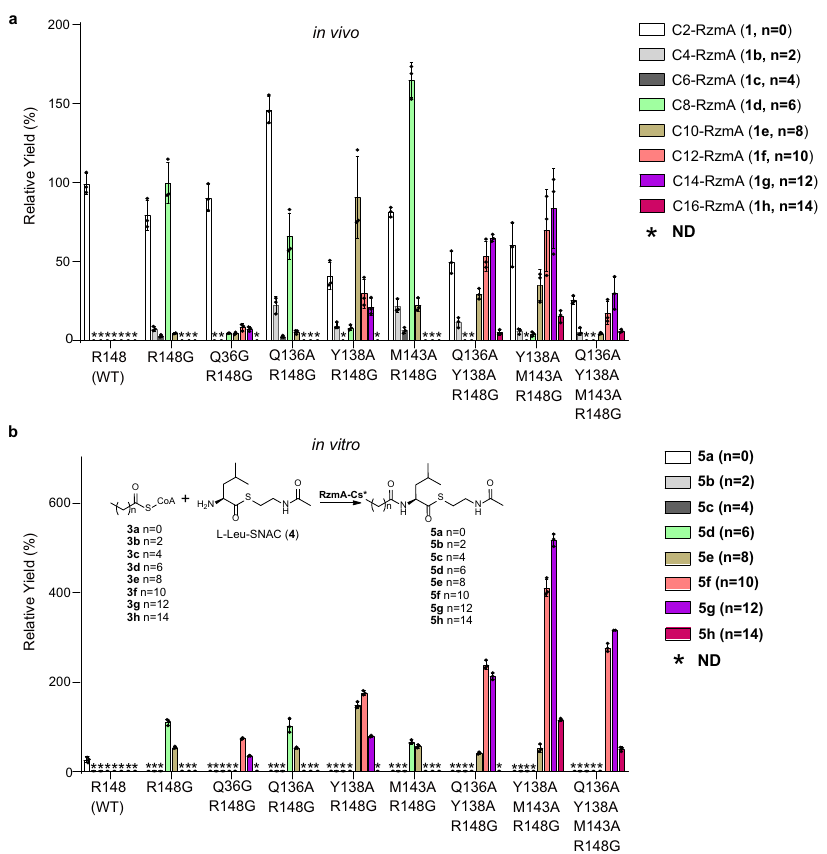
Fig. 7 Structure-guided in-depth engineering of the Cs domain of rhizomide. a The relative yields of rhizomide derivatives ( 1 , 1b – 1h ) with different acyl chains (C2-C16) in S. brevitalea DSM 7029 harboring the corresponding point-mutated rzmA . The yield of 1d (C8-RzmA) in RzmA-R148G was quanti fi ed as a reference (100%) for the peak areas of EICs. Related chemical structures of rhizomide derivatives were given in Fig. 1b in which the ‘ n ’ represents the number of CH 2 group. b The relative yields of acyl-Leu-SNAC ( 5a – 5h ) in the in vitro acyl-CoAs substrate competition experiment of RzmA-Cs variants. The yield of 5d (C8-Leu-SNAC) in RzmA-Cs R148G was quanti fi ed as a reference (100%) for the peak areas of EICs. The products that were not detected (ND) by UPLC-MS are marked with asterisks. Experiments were conducted in triplicates ( n = 3), data are presented as mean values + / − SD. The source data is provided in the Source data fi